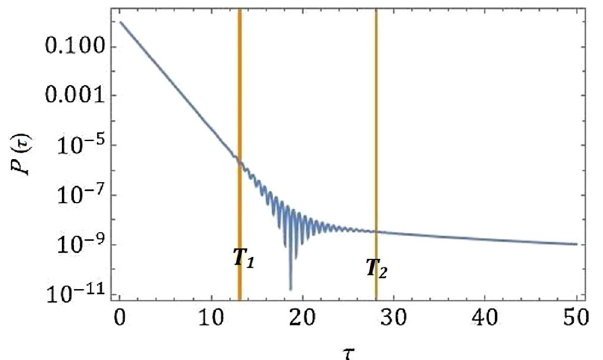
Fig. 4 The instantaneous decay rate Γ ( t ) obtained for ω BW ( E ) given by Eq. (28). The case β = 100. τ = t τ time. The solid line: The ratio Γ ( t )/Γ 0 . The dashed line: Γ ( t ) = Γ 0